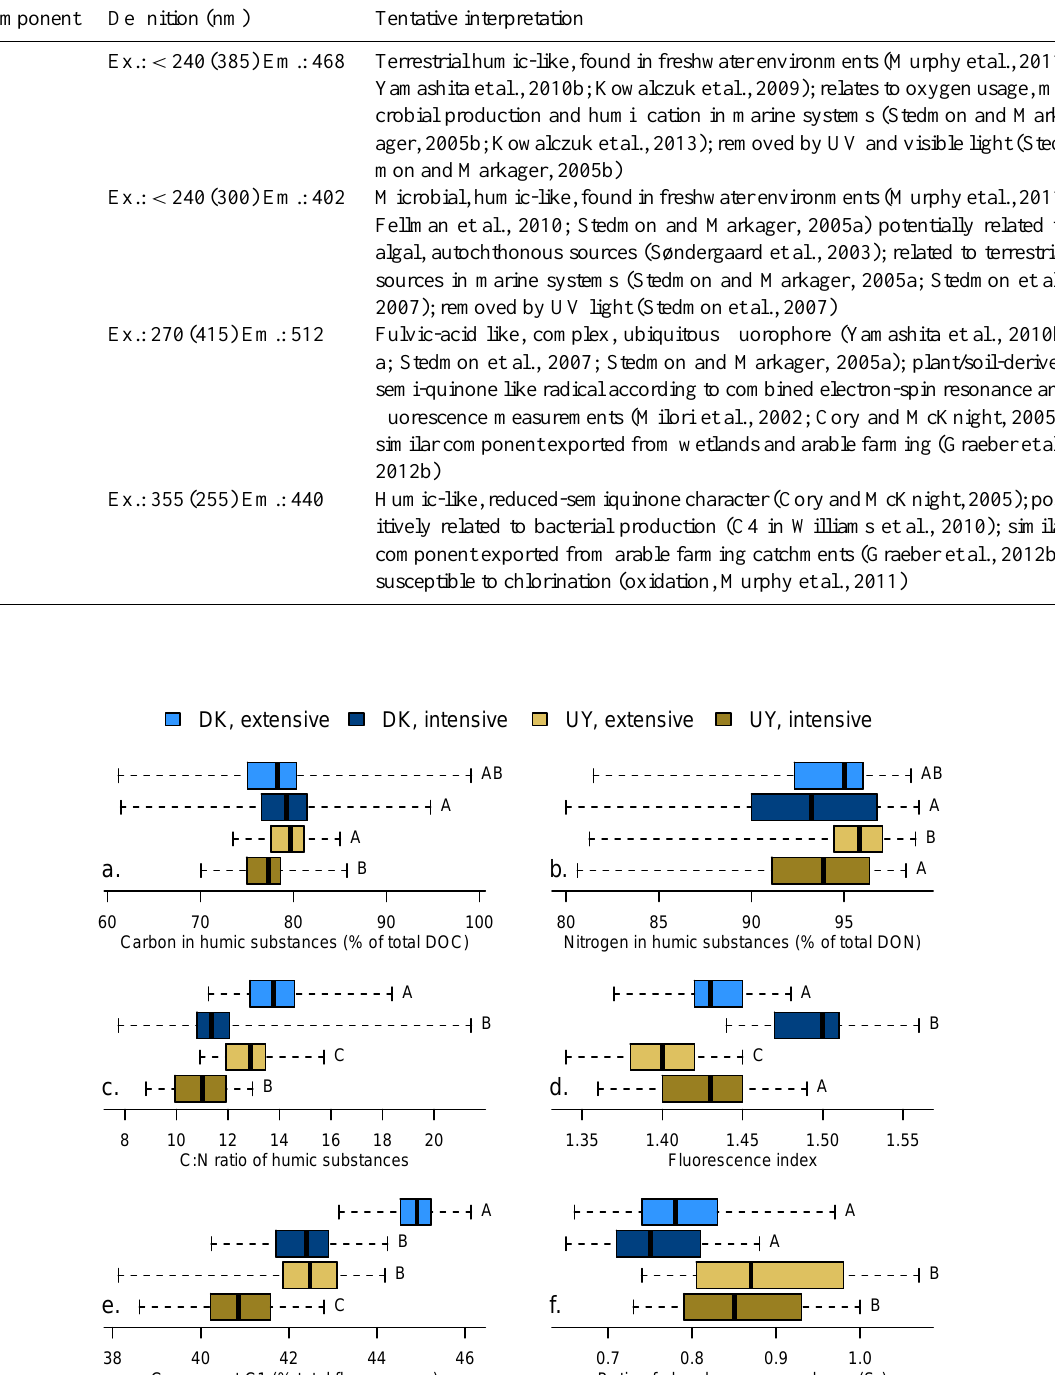
Table 3. Excitation maxima (Ex., secondary maxima in parentheses), emission maximum (Em.) and tentative interpretation of fluorescence components based on parallel factor analysis (PARAFAC).